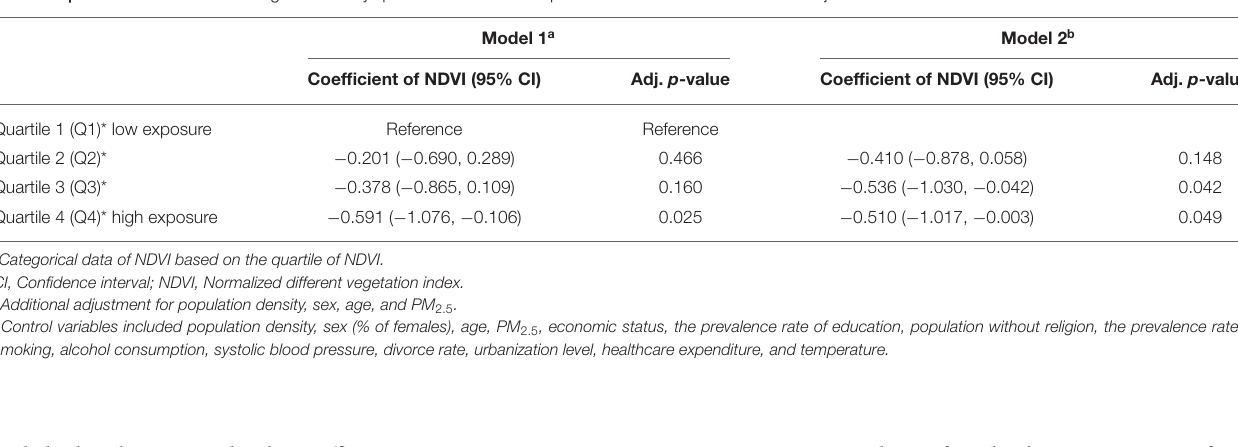
TABLE 3 | Coefficient estimations of greenness by quartile attributed to depressive disorders in multivariable adjusted